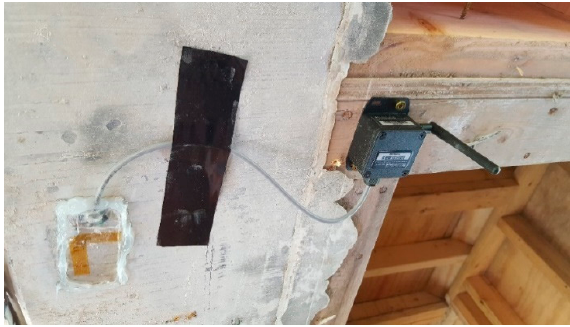
Figure 9. Installed strain gauge and wireless transmitter.